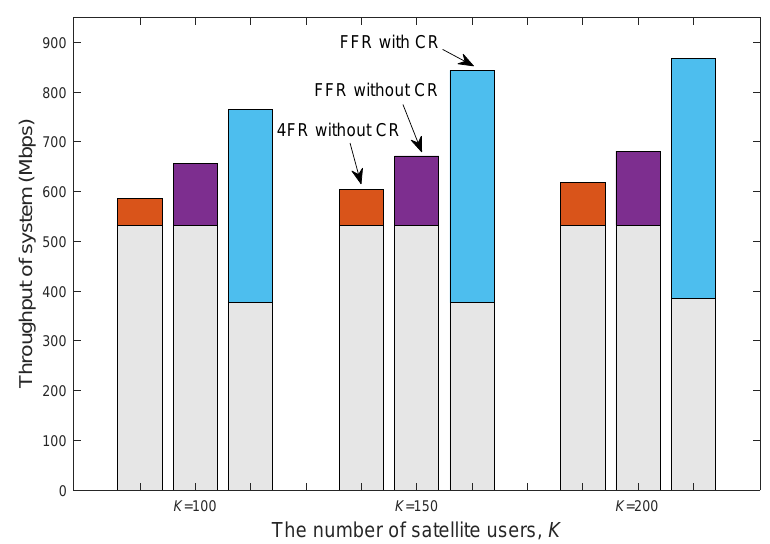
Figure 6. System throughput of different schemes with varying satellite user numbers. The lower and upper parts of each bar correspond to the throughputs of terrestrial and satellite communications, respectively. ( N t = 256, N g = 10, and β = 10).